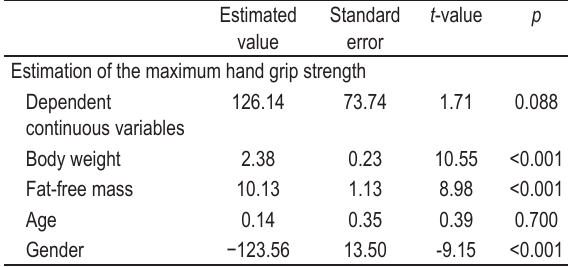
TABLE 3. Estimation of the maximum hand grip strength using the values of body weight, fat-free mass, age, and gender on the basis of